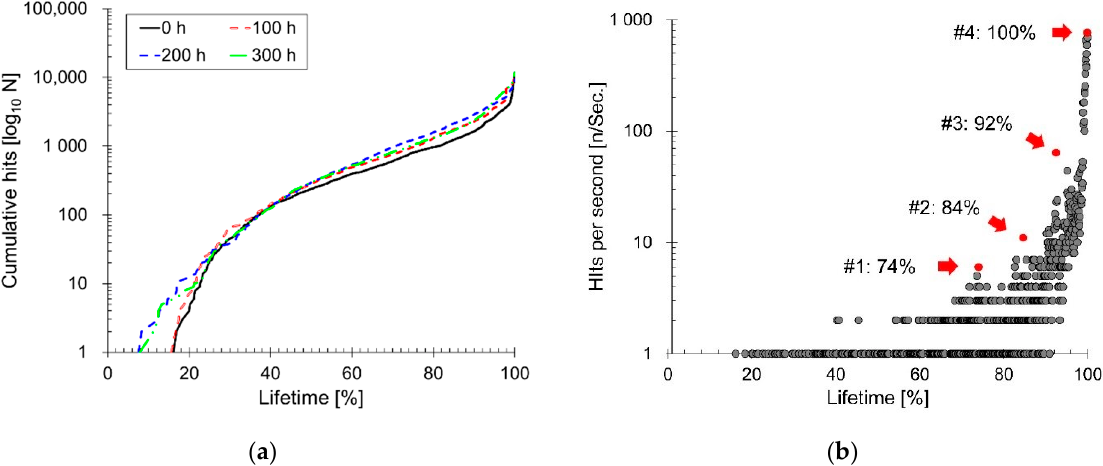
Figure 8. Acoustic emission (AE) hit distribution. ( a ) Cumulative AE hits and ( b ) AE occurrence rate (hits per second) for the 0 h specimen.